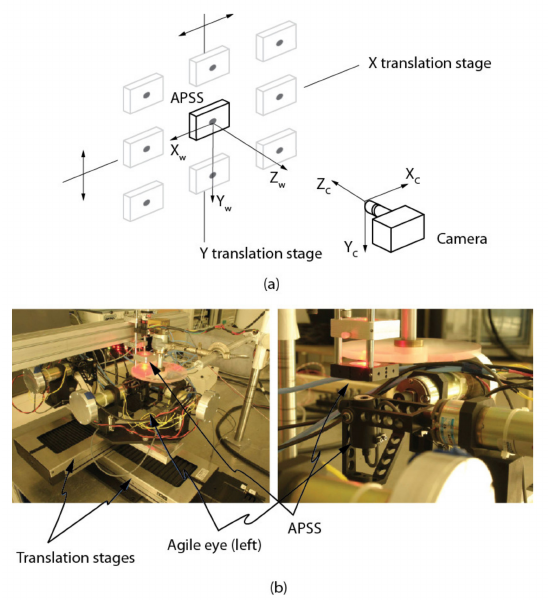
Figure 16. Estimation of the position of the APSS in the reference frame of the camera. The APSS is mounted on two precision linear stages (not shown in the diagram) and is moved at different known locations in frame O W . The center of gravity of the image of the circle on the image plane is found at each position. This operation mimics the operation of imaging a calibration target and finding correspondences between image points in the image reference frame and calibration points on the target ( a ). Linear stages, APSS and left eye of the ASP (left); APSS and camera of the left eye of the ASP pointing upward (right) ( b